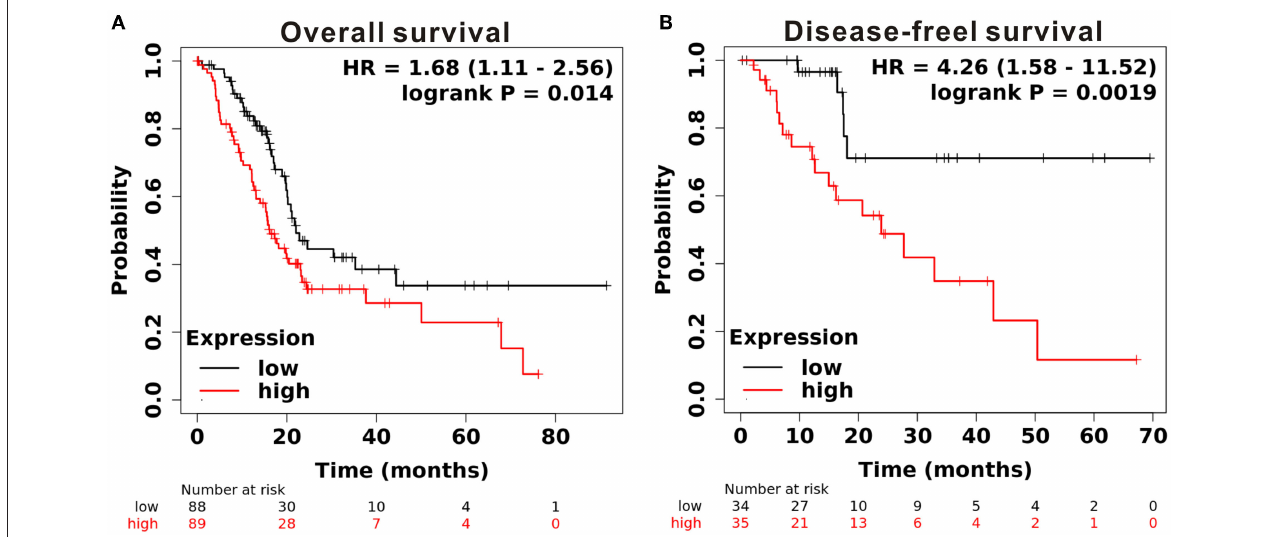
FIGURE 3 | Prognostic significance of CAPN2 mRNA levels in patients with PC. (A) Patients with high CAPN2 mRNA levels showed poorer OS than patients with low CAPN2 levels in the Kaplan–Meier Plotter database ( N = 177, HR = 1.68, P = 0.014). (B) Patients with high CAPN2 mRNA levels showed poorer RFS than patients with low CAPN2 mRNA levels in the Kaplan–Meier Plotter database ( N = 69, HR = 4.26, P =